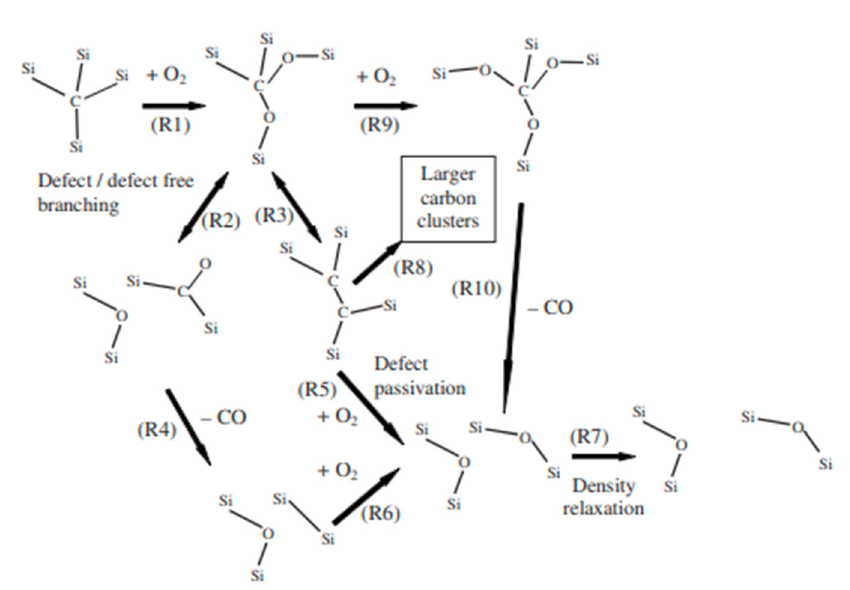
Figure 12. The scheme of the kinetic mechanism of the (0001) SiC surface oxidation process. Reprinted with permission from Reference [54]. Copyright 2008 AIP Publishing.